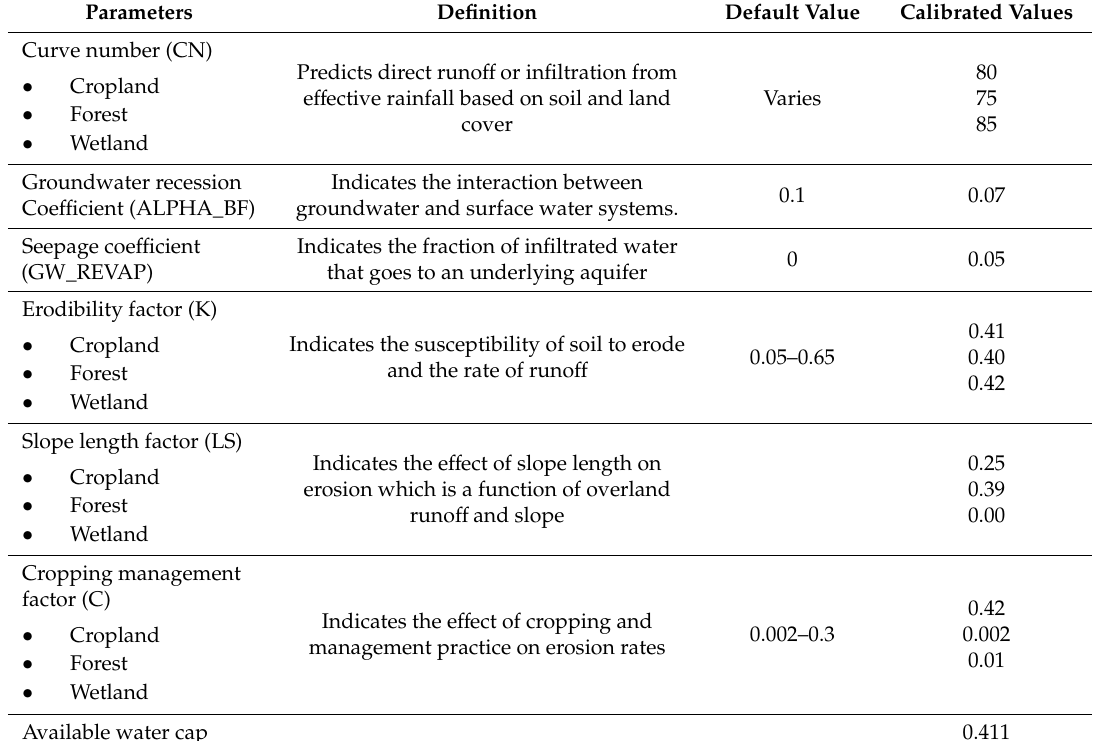
Table 3. Calibrated parameters of the MapShed